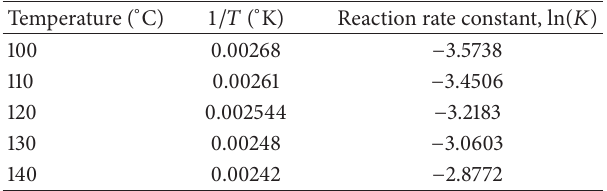
Table 2: Rate of reaction constant ln( 𝐾 ) of recycled PVC resin at different temperatures (100–140 ∘